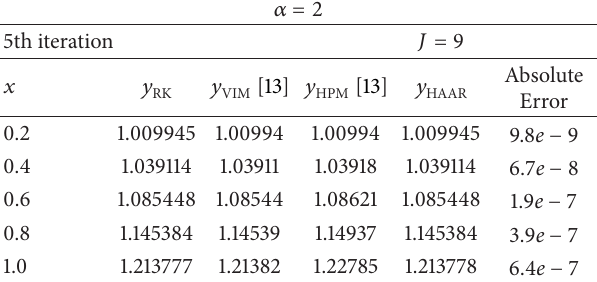
Table 2: Double-well situation: comparison of solutions by the Haar at 5th iteration and level wavelet-quasilinearization technique 𝑦 HAAR of resolutions 𝐽 = 9 with numerical methods [13] and numerical solution based on the fourth-order Runge-Kutta.